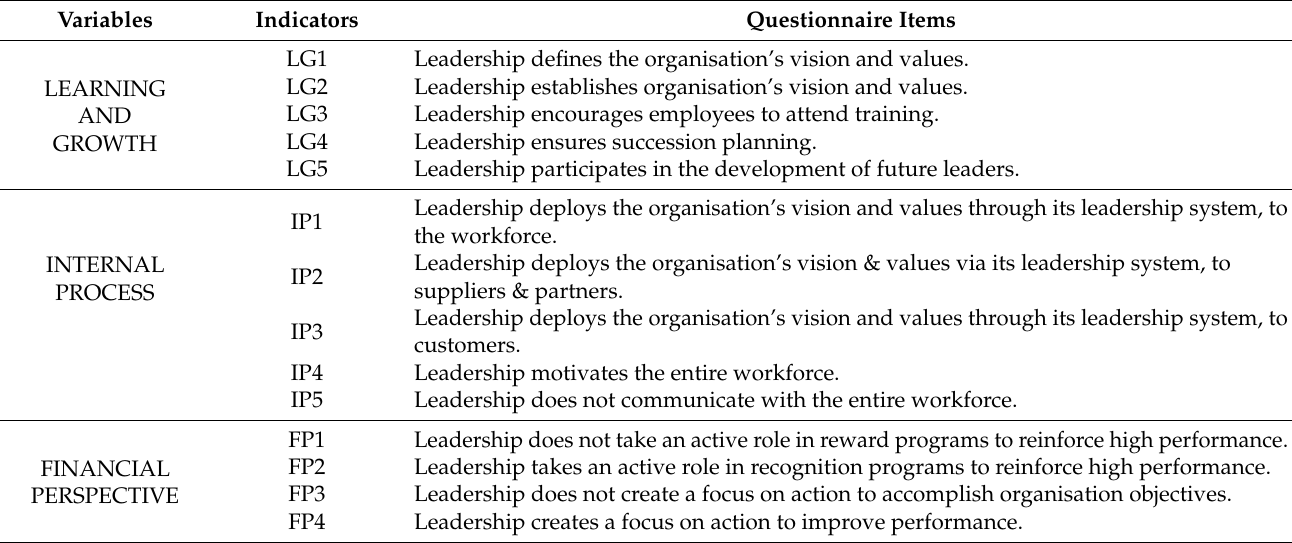
Table A2. Questionnaire items addressing the OP variables and